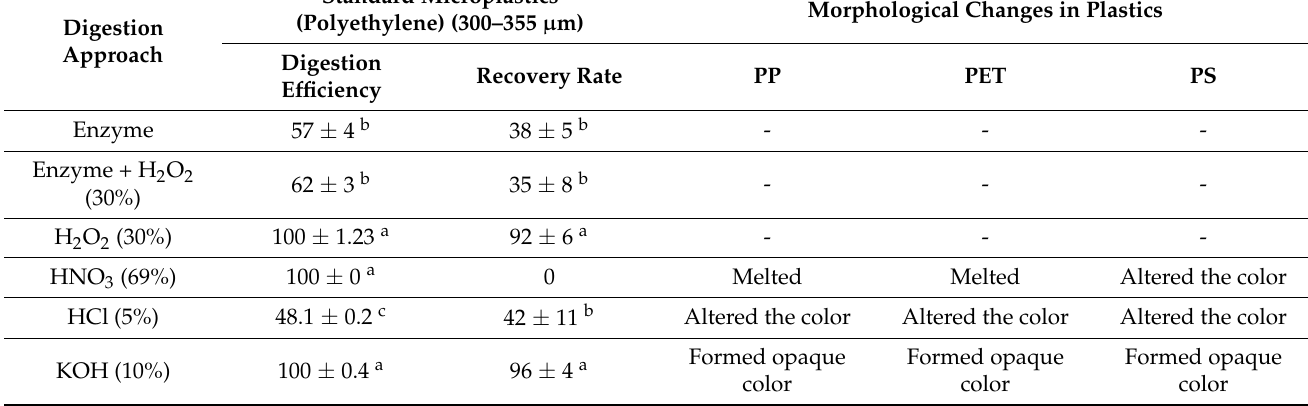
Table 2. The impact of digestion approaches on digestion efficiency, recovery rate, and morphological